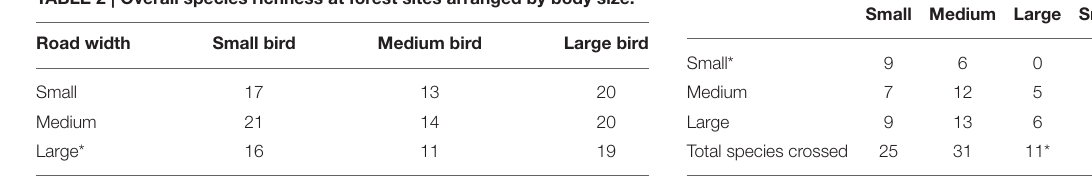
TABLE 2 | Overall species richness at forest sites arranged by body size.